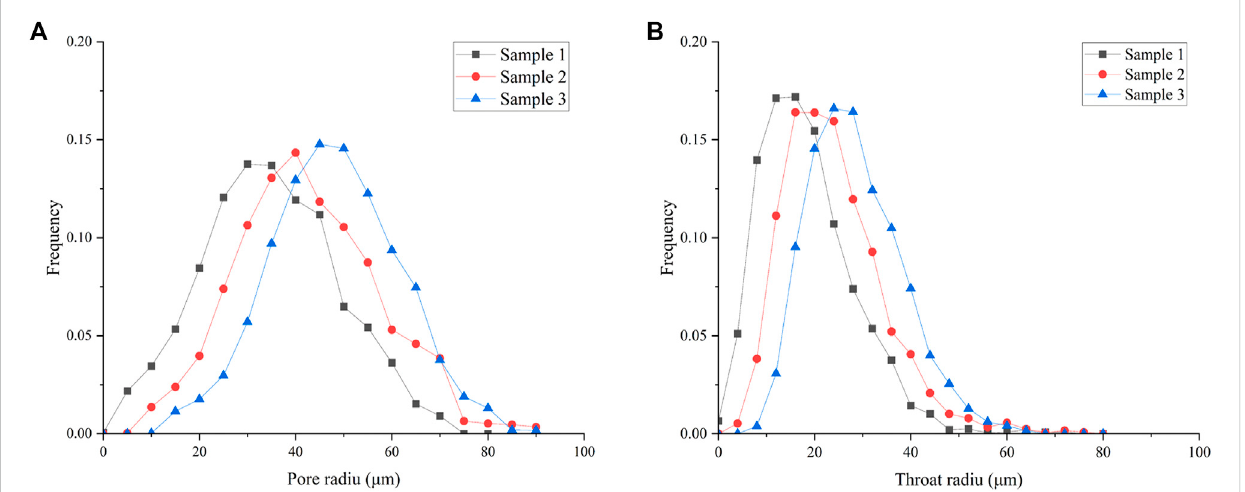
FIGURE 1 Distribution frequencies of the pore-throat radii of three samples. (A) Frequencies of pore radius distributions. (B) Frequencies of throat radius